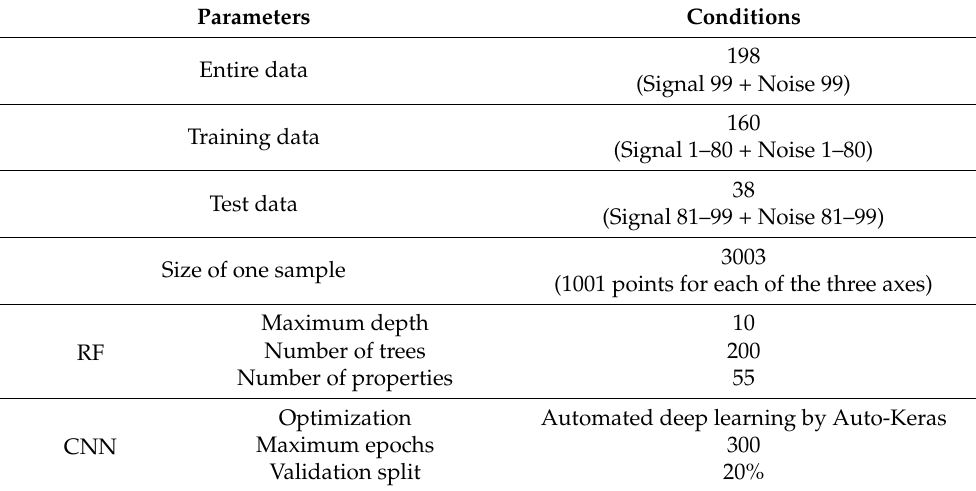
Table 1. Conditions for training of RF and